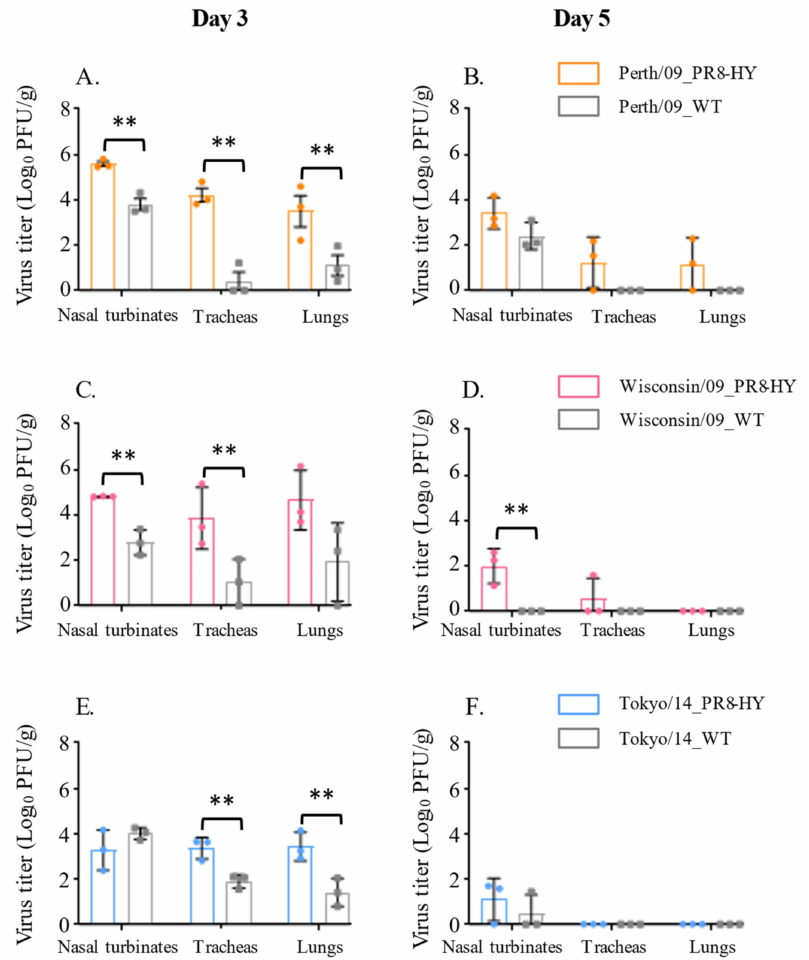
Figure 1. Replication of authentic and PR8-HY-based human H3N2 viruses in Syrian hamsters. Syrian hamsters (six per virus) were infected with 10 6 PFU of wild-type isolate or recombinant virus with the respective HA and NA genes on the PR8-HY backbone. On days 3 and 5 p.i., three animals from each group were euthanized and virus titers in the nasal turbinates, tracheas, and lungs were determined in hCK cells; ** p < 0.01. ( A , C , E ) show the titers of the indicated viruses on day 3 post-infection; ( B , D , F ) show the titers of the indicated viruses on day 5